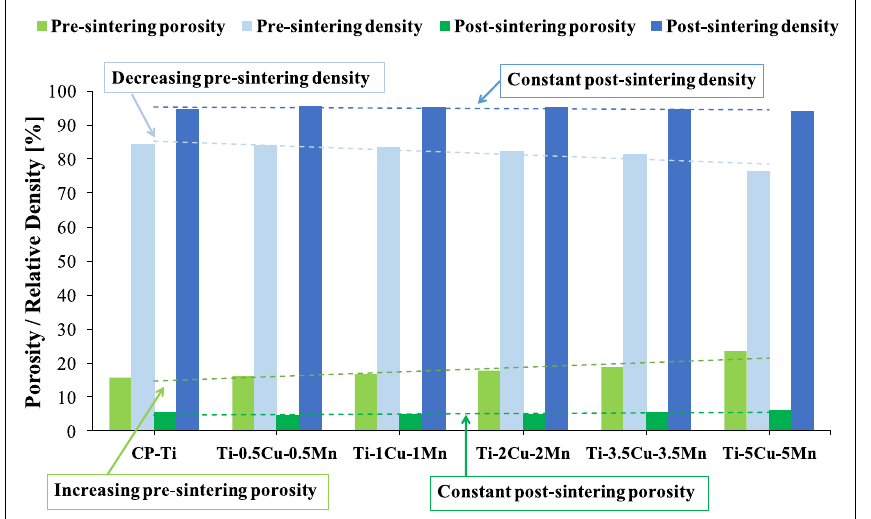
Figure 3. Variation of the porosity and relative density before and after the sintering of CP Ti and of the β eutectoid bearing functionalised Ti